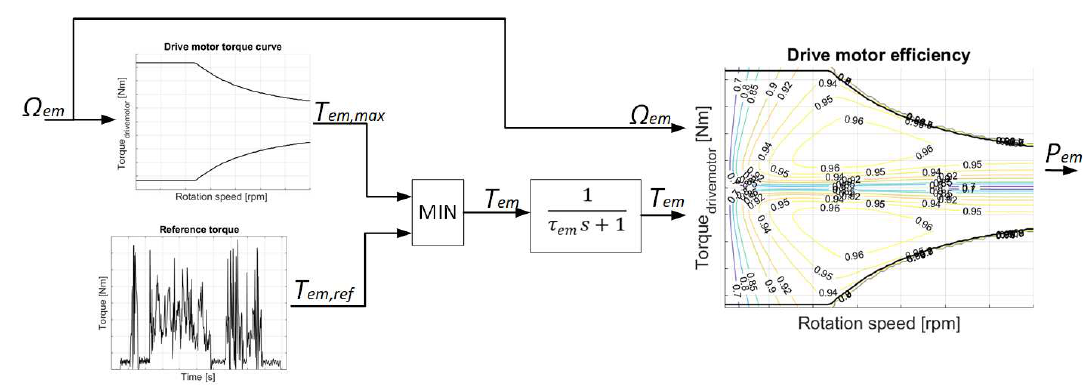
Figure 5: Block diagram of electrical drive